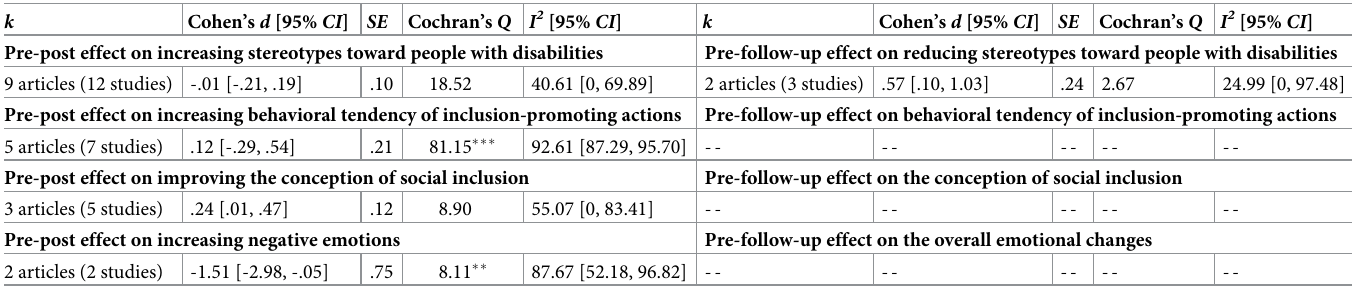
Table 1. Effect sizes of the studies included for